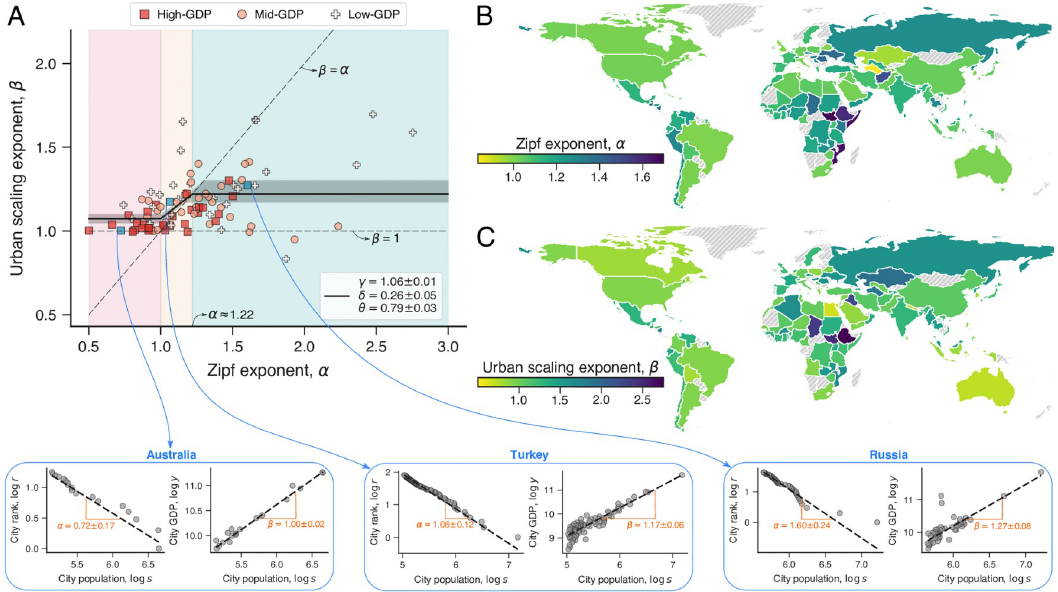
Fig 1. Association between the urban scaling exponent β and the Zipf exponent α . (A) Values of β versus α for each country in our data set. The three different markers distinguish countries according to the tercile values of the total urban GDP distribution (for instance, high-GDP countries have highest � 33% GDP values). The horizontal dashed line shows the β = 1 while the inclined dashed line represents the β = α relationship. As we shall discuss in the next section, the continuous line shows the model of Eq (9) adjusted to data and the gray shaded region stands for the 95% confidence band. The colored background represents the different intervals of α defined in Eq (9). The insets (indicated by blue arrows) illustrate Zipf’s law for city population (left) and the urban scaling relationship of city GDP (right) for three countries (see S1 Appendix, Sec. 4 for all considered countries). We have verified that the model of Eq (9) provides a significantly better description of data when compared with a null model where β is independent of α (intercept-only model: β = constant, see Fig 4 in S1 Appendix), and that statistical correlations between β and α are significantly enhanced in the (orange shaded) region where our model predicts a linear correspondence between the exponents (Fig 5 in S1 Appendix). Maps in panels (B) and (C) show the color-coded values of α and β for each country (light gray indicates missing values).